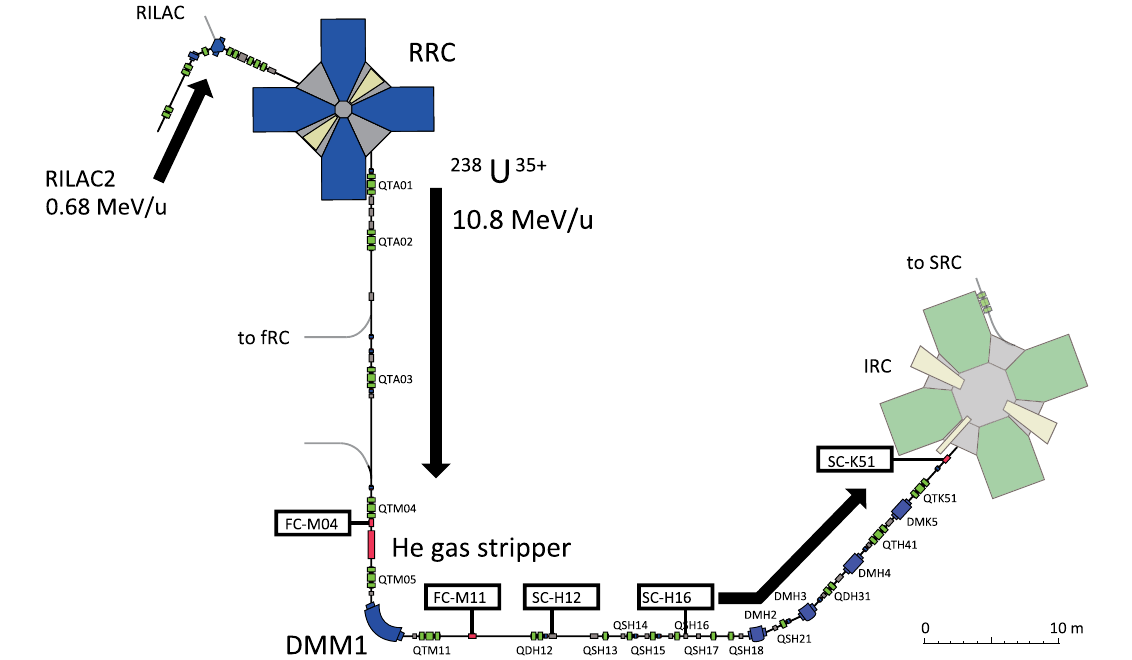
FIG. 4. Schematic view of the entire experimental setup. The RRC accelerates U 35 þ beams coming from RILAC2 to an energy of 10 : 8 MeV = u . The emitted beams of around 150 enA are fed into the He gas stripper. The charge-state distribution of the passing beams is analyzed using a dipole magnet, DMM1, and a Faraday cup, FC-M11. Plastic scintillators (SC-H12, SC-H16, and SC-K51) are used to measure the beam’s kinetic energy and longitudinal distribution. Many quadrupole magnets (QS*: singlet; QD*: doublet; QT*: triplet) were used in the beam transport system to optimize the beam